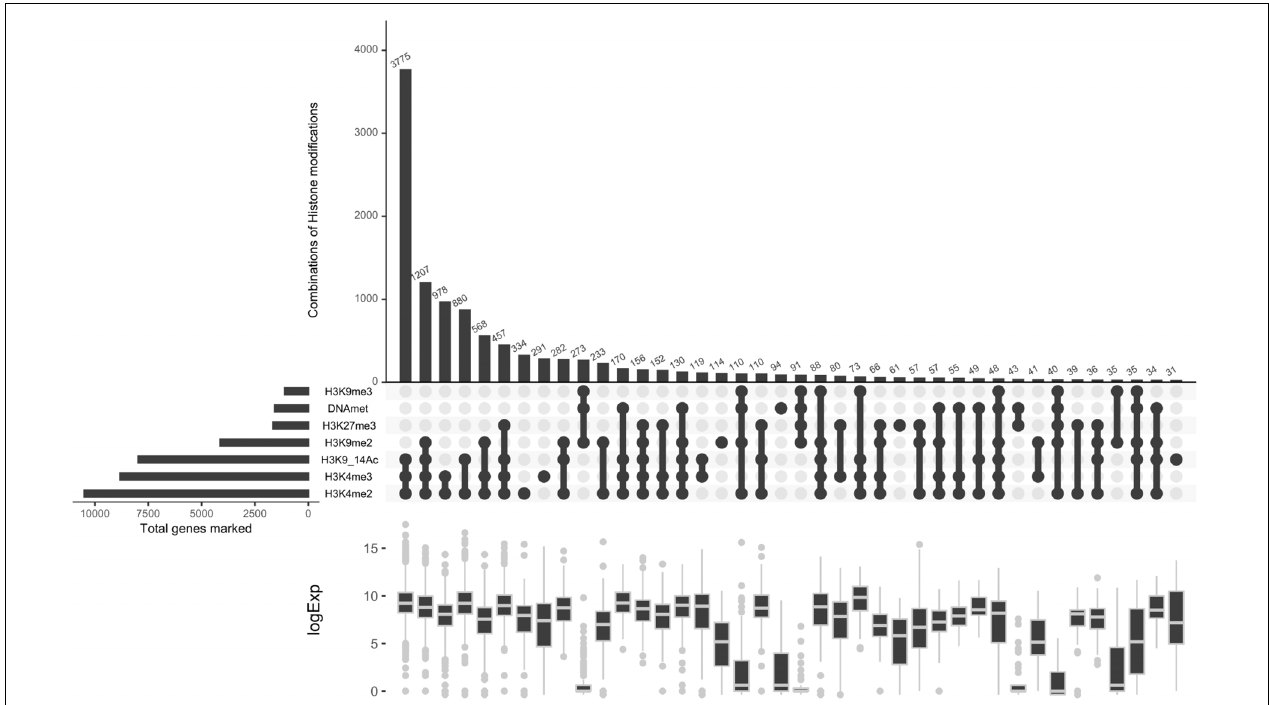
FIGURE 8 | Co-occurrence analysis. A co-occurrence plot for the ChIP-seq peaks of different histone modification. For each set of intersection, a black filled circle is drawn. The size of the intersections is depicted in vertical bar. The vertical black line connects the different dataset that intersect. The number of genes for each chromatin state is shown on the top of the